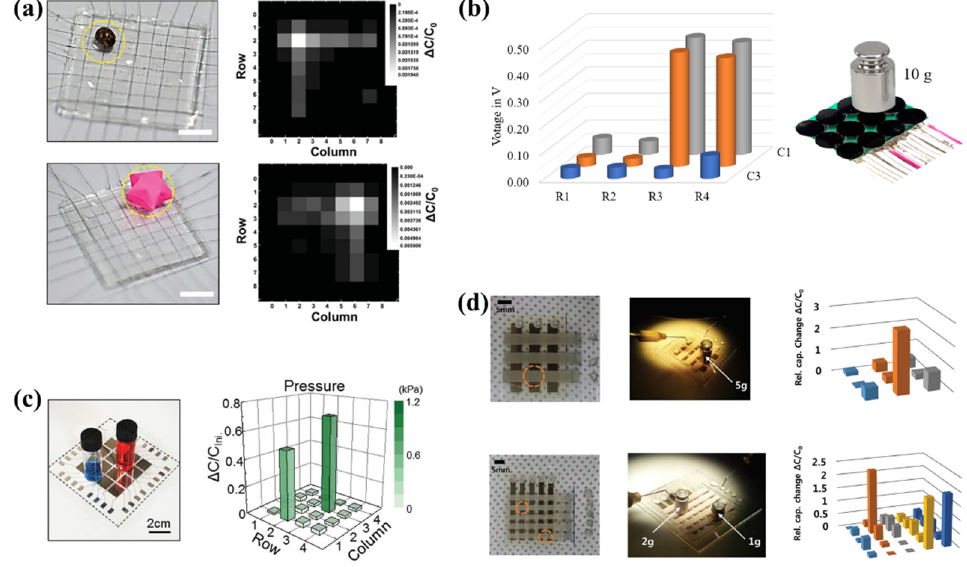
Figure 9. Various types of sensor arrays. ( a ) CNT microyarn-based sensor array. Reproduced with permission from [153], Copyright (2015), Wiley-VCH. ( b ) MWCNT / PDMS composite. Reproduced from [140]. ( c ) SWCNT-embedded PDMS with pyramidal patterns. Reproduced with permission from [154], Copyright (2018), Wiley-VCH. ( d ) Ag NW-embedded wavy PDMS. Reproduced with permission from [134], Copyright (2015), Royal Society of Chemistry.